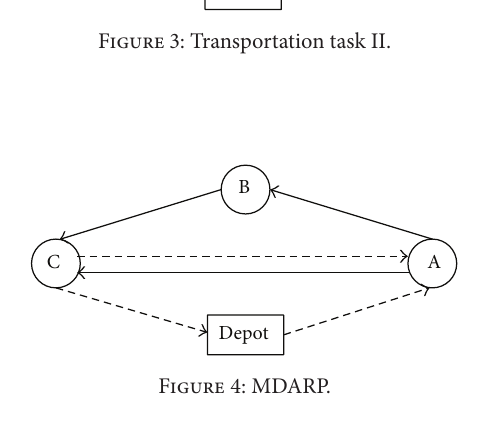
Figure 2: Collaborative transportation.